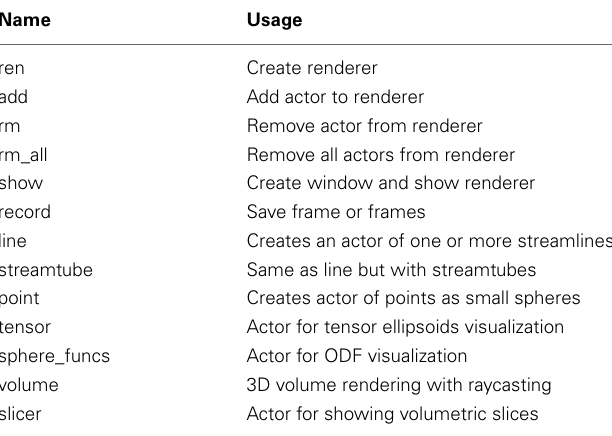
Table 1 | List of visualization